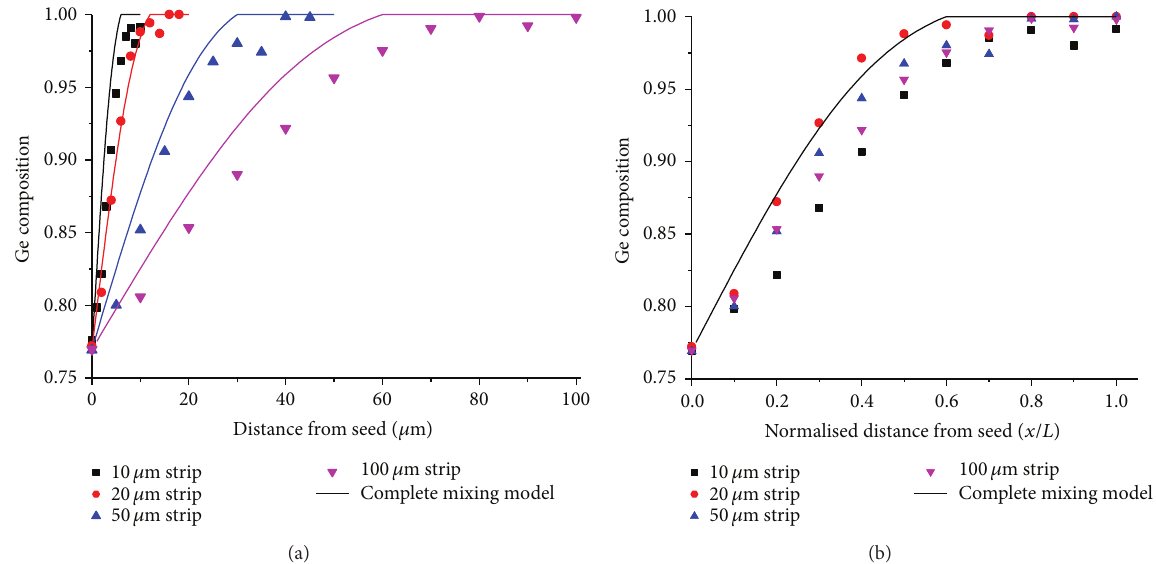
Figure 4: SiGe composition profiles for a range of straight strip lengths: (a) as a function of distance from the seed and (b) normalised by dividing the distance from the seed by the total strip length. Strip width = 5 𝜇 m. Estimated maximum SiGe temperature = 1008 ∘ C. The strips have been fitted with the complete mixing model [33].